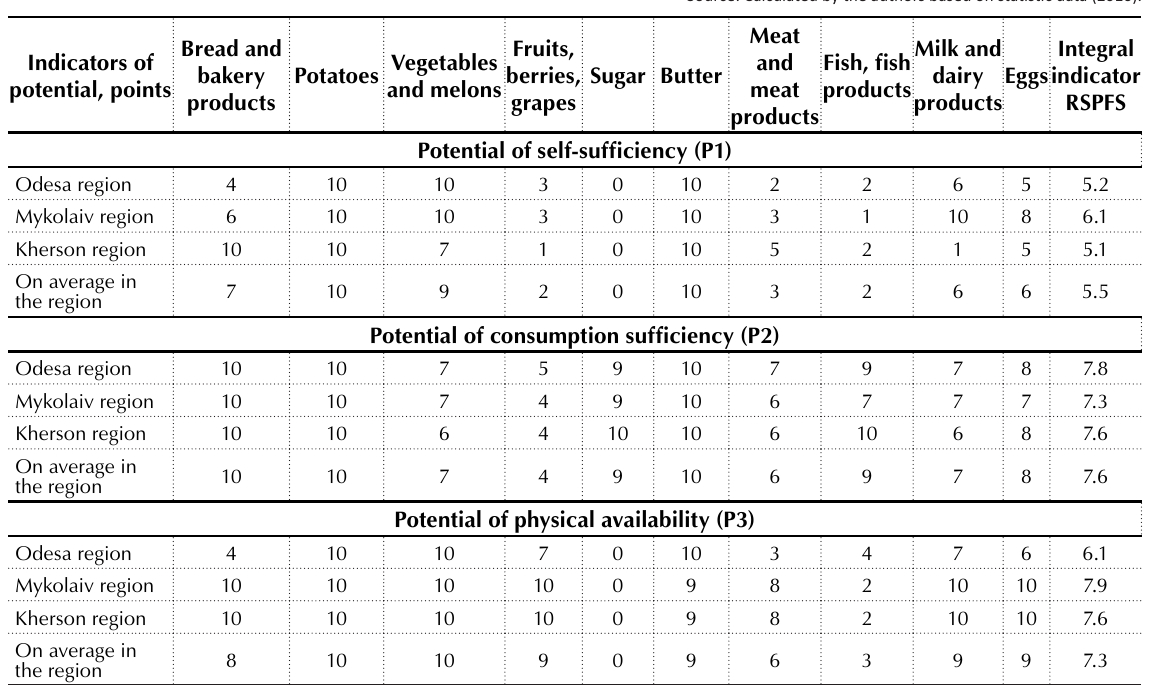
Table 3. The level of food security potential of the Black Sea region in